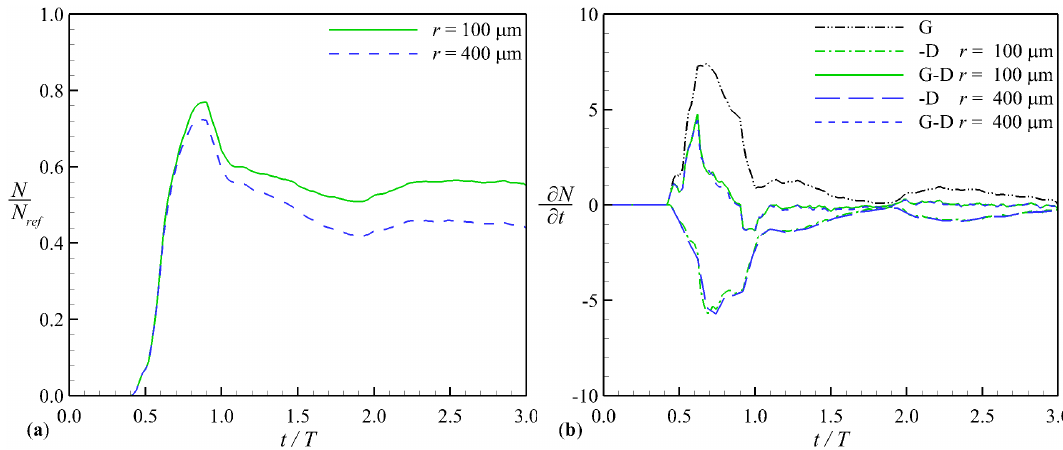
Figure 8. Time histories of ( a ) the number of droplets N / N ref , and ( b ) generation rate GT / N ref and disappearance rate − DT / N ref of droplets in Case